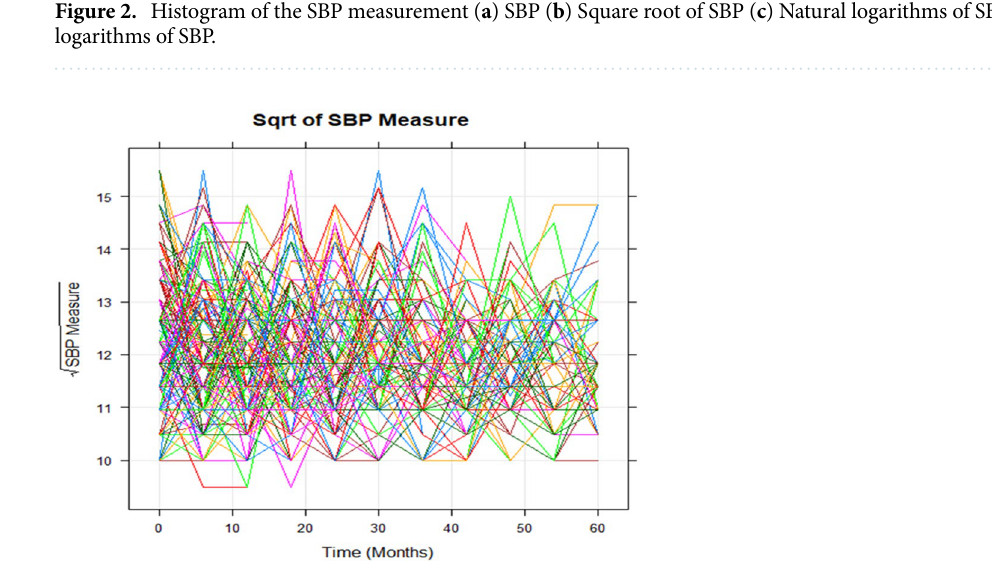
Figure 3. Plot of the individual profile of SBP of hypertension patients in follow up